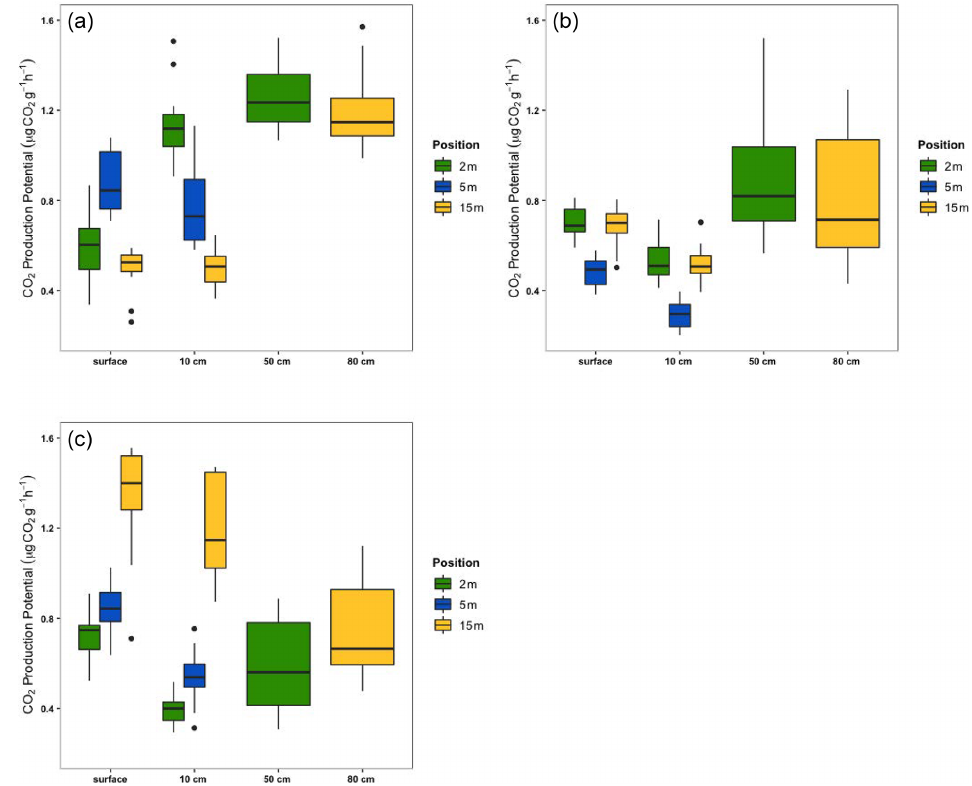
Figure 9. CO 2 production potentials of all samples from the (a) 1987, (b) 2007, and (c) 2016